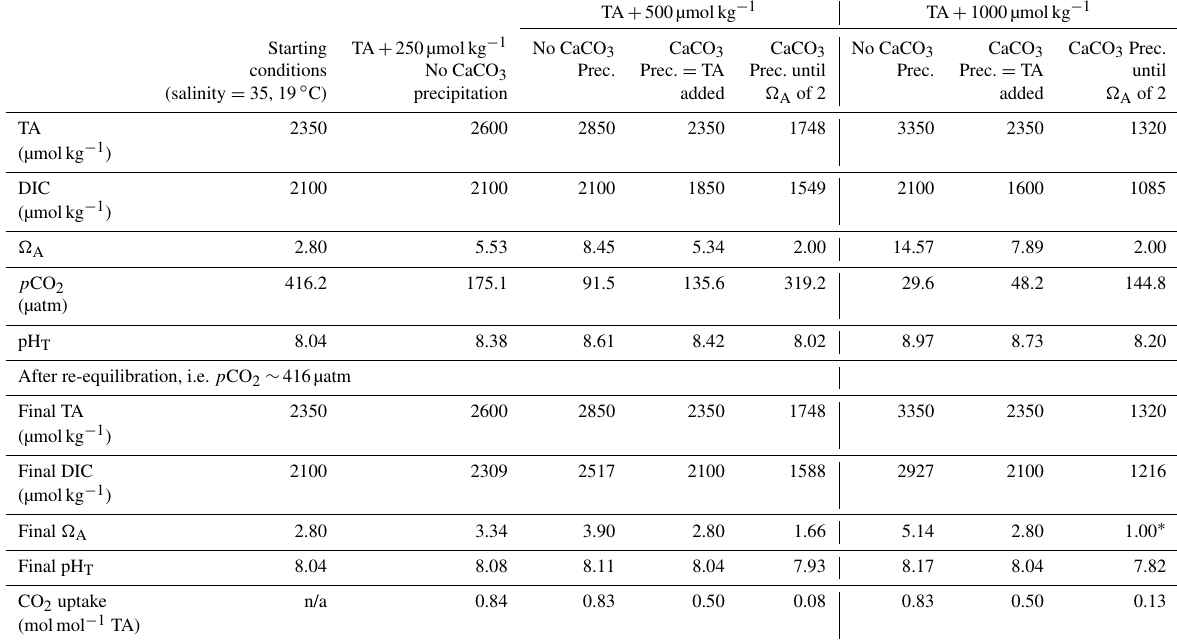
Table 3. Simulations of the changes in TA, DIC, (cid:127) A , p CO 2 and pH T (total scale) after TA increases of 250, 500 and 1000µmolkg − 1 , assuming complete mineral dissolution without precipitation, a complete dissolution followed by as much CaCO 3 precipitated as the amount of TA added and a complete dissolution followed by CaCO 3 precipitation until reaching an (cid:127) A of 2.0, before CO 2 re-equilibration to initial p CO 2 . For each scenario, the number of moles of CO 2 absorbed per mole of TA added has been calculated for comparison. The 500µmolkg − 1 TA addition simulation is shown in Fig. A3 in the Appendix. TA + 500µmolkg −